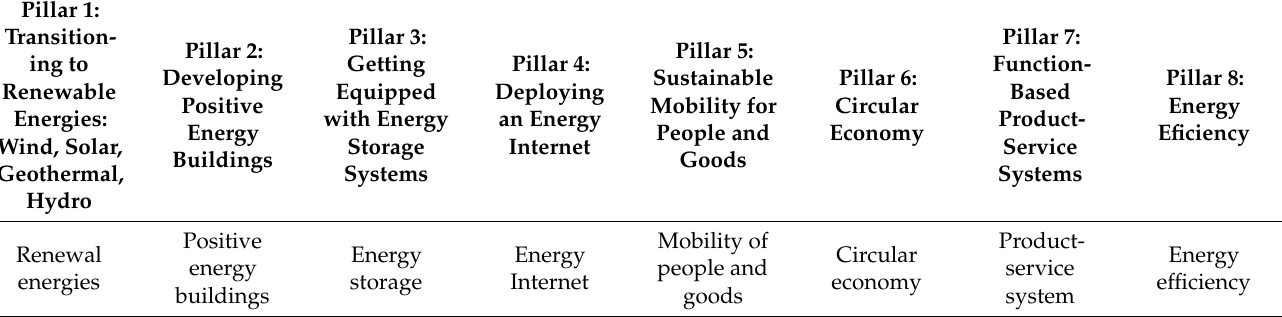
Table A2. Key words used in the search on ASTRIDE—Hauts-de-France Innovation D é veloppement.